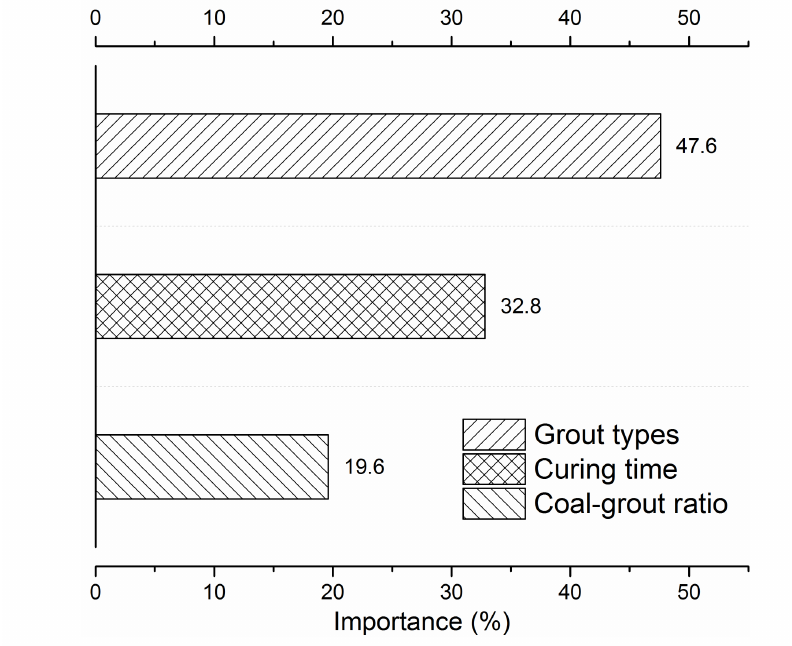
Figure 11. Variable importance of the coal-grout